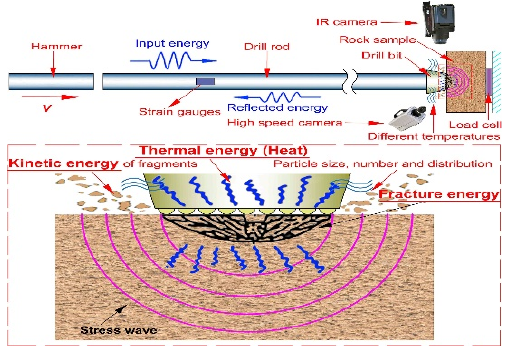
Fig. 5. The schematic picture of the experiment used to evaluate the energy consumption during percussive